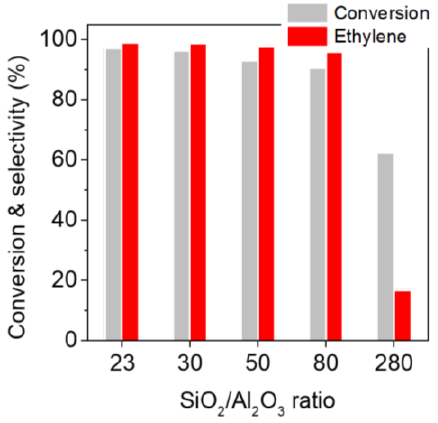
Figure 1. Ethanol conversion ( ■ ) and selectivity to ethylene ( ■ ) obtained after 20 h on stream as a function of SiO 2 /Al 2 O 3 ratio of H-ZSM-5 in dehydration of bioethanol at 250 °C and 5 h − 1 WHSV (0.2 g of catalyst and 0.021 mL min − 1 of ethanol).